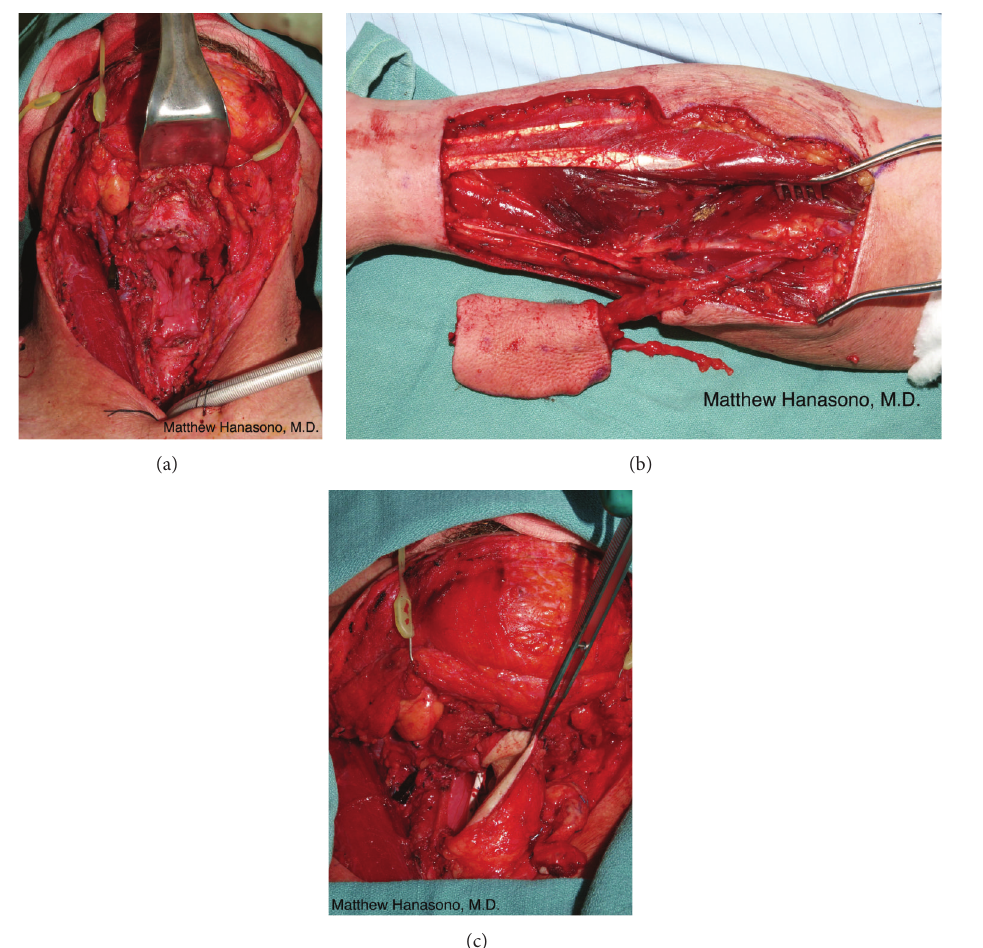
Figure 11: A partial circumference pharyngeal defect following a laryngopharyngectomy for recurrent laryngeal cancer (a). A radial forearm free flap was harvested for reconstruction (b). Flap inset over a nasogastric feeding tube